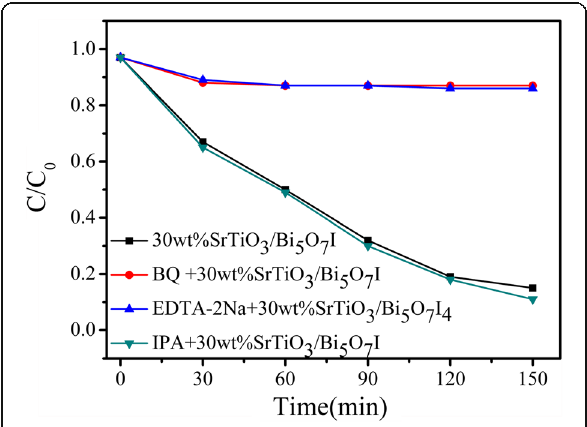
Fig. 7 The degradation efficiency constant of RhB over the 30 wt% SrTiO 3 /Bi 5 O 7 I nanocomposite in the presence of various